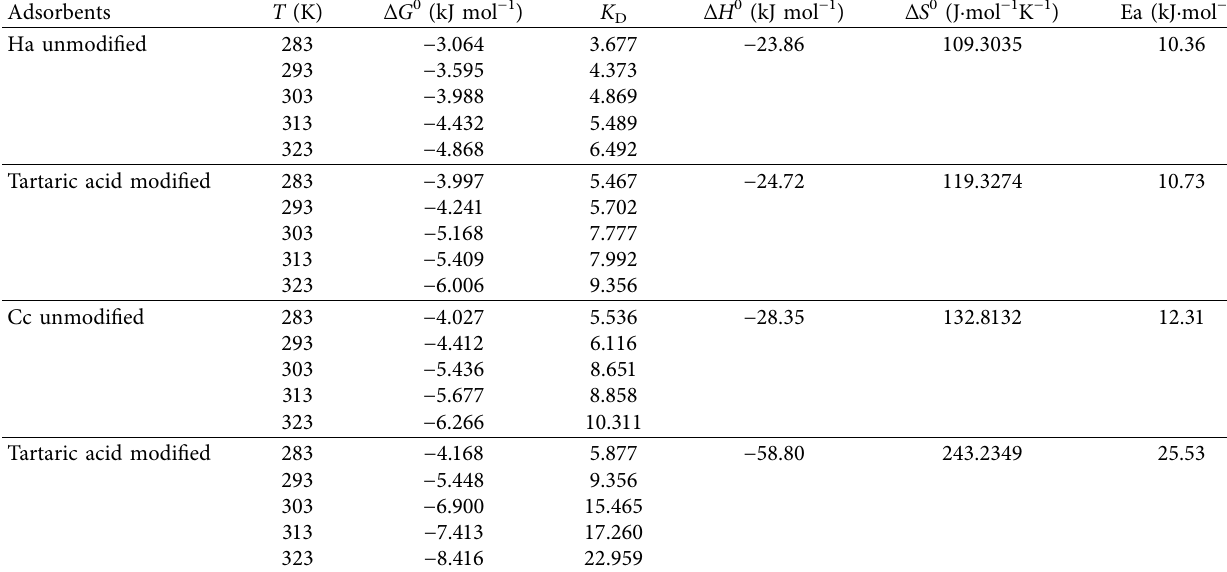
Table 3: Thermodynamic parameters for BG dye